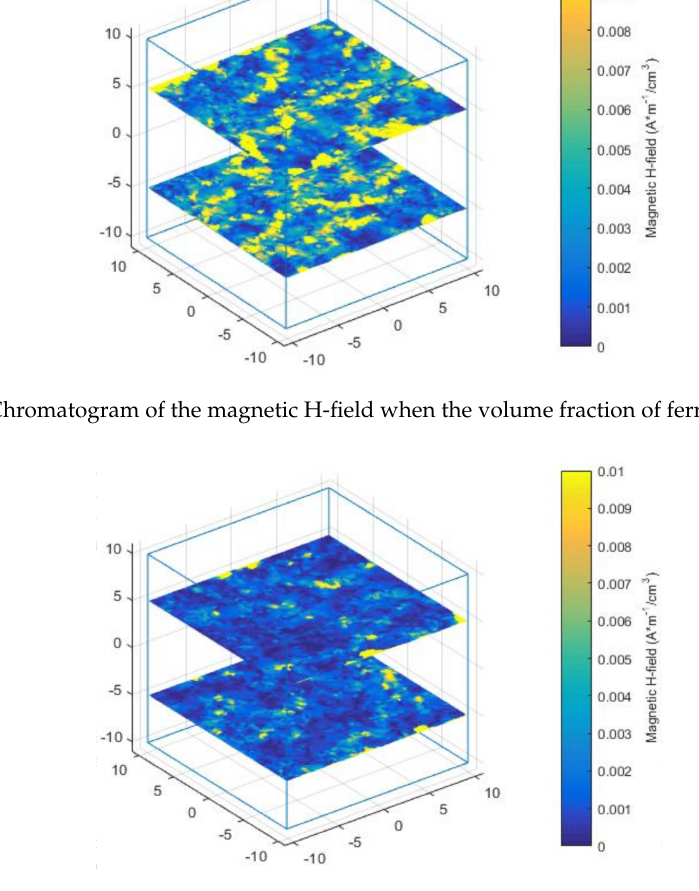
Figure 8. Chromatogram of the magnetic H-field when the volume fraction of ferrite grains is